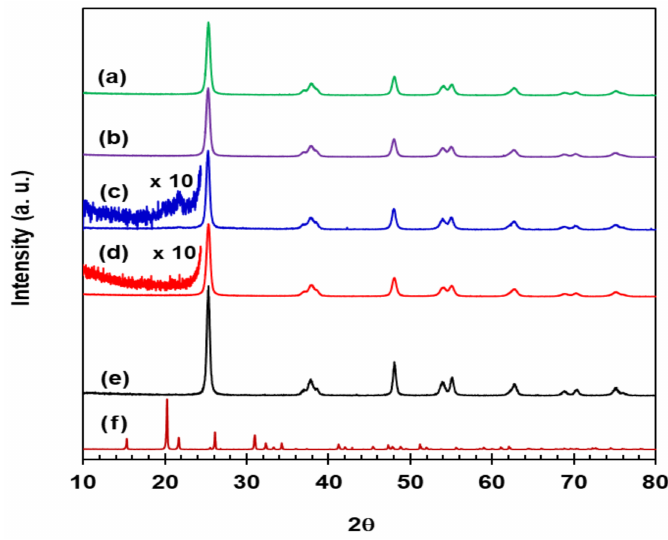
Figure 1. XRD patterns for: ( a ) VWT; ( b ) 2.73% Fe 2 O 3 /VWT; ( c ) c-VWT; ( d ) 2.73% Fe 2 O 3 /c-VWT; ( e ) pure anatase TiO 2 ; and ( f ) α -phase orthorhombic V 2 O 5 . Comparing hematite ( α -Fe 2 O 3 ), maghemite ( γ -Fe 2 O 3 ), magnetite (Fe 3 O 4 ), goethite ( α -FeOOH), akaganeite ( β -FeOOH), lepidocrocite ( γ -FeOOH), and feroxyhyte ( δ -FeOOH) in the corresponding JCPDS card #s 33-0664, 39-1346, 02-1035, 29-0713, 34-1266, 08-98, and 29-712, neither of them